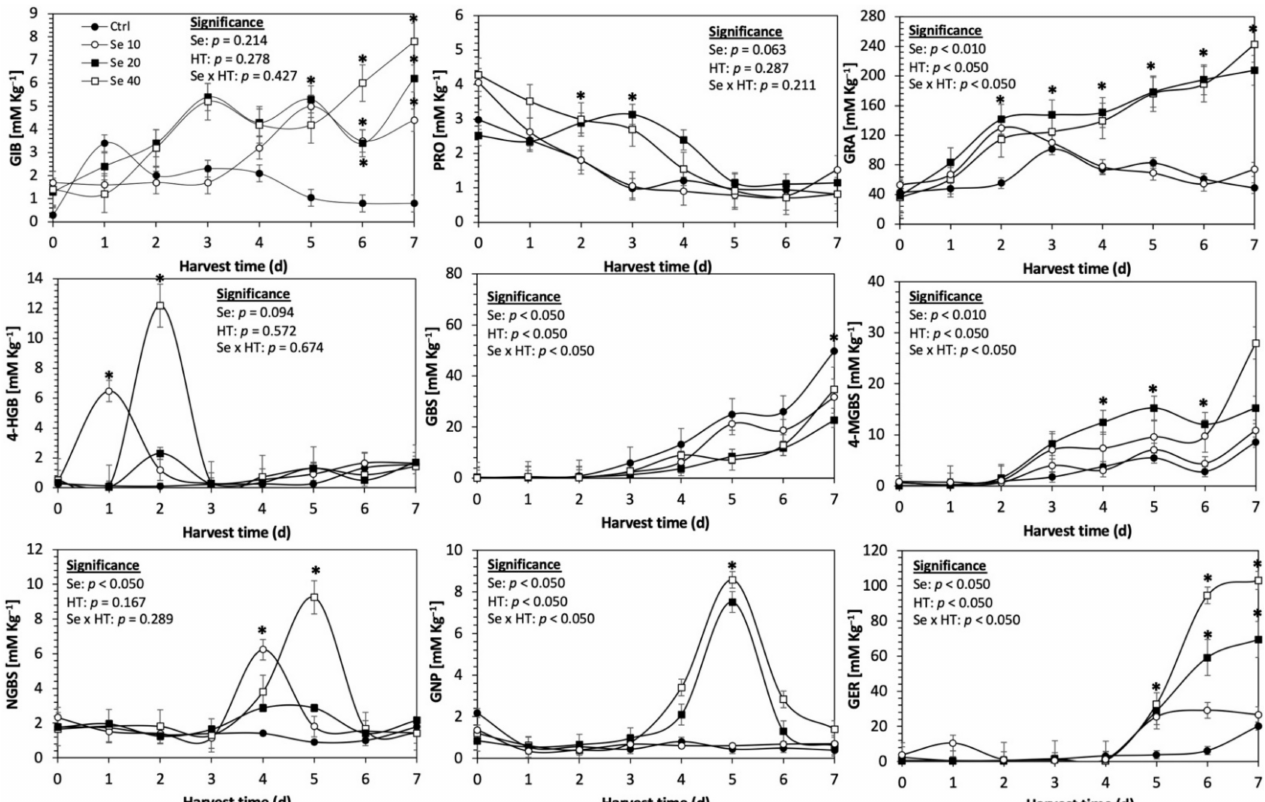
Figure 4. Concentration of individual glucosinolates in untreated Red Russian kale sprouts treated with selenium during the first 7 days of germination. Bars are means of 3 replicates ± standard error. Data points with an asterisk (*) indicate statistical difference determined by a t -test ( p < 0.050) between the control and treated samples. Abbreviations: selenium (Se), harvest time (HT), glucoiberin (GIB), progoitrin (PRO), glucoraphanin (GRA), 4-hydroxy-glucobrassicin (4-HGB), glucobrassicin (GBS), 4-methoxy-glucobrassicin (4-MGBS), glucoeurocin (GER), gluconapin (GNP), and neoglucobrassicin (NGBS). Results are expressed as desulfogucoraphanin equivalents in dry weight